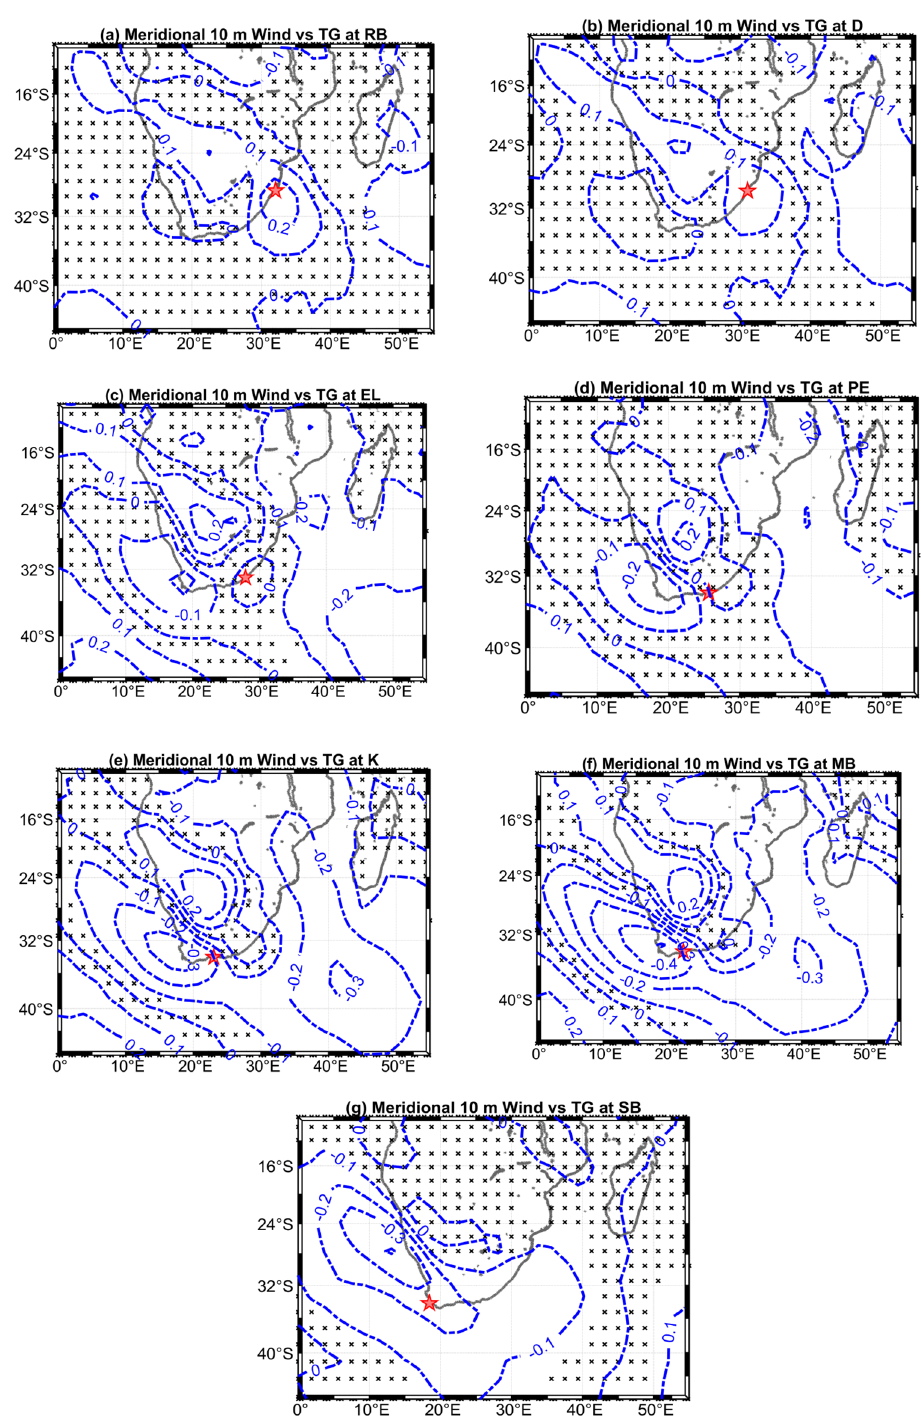
Figure 4. Correlation, on sub-annual timescale, between regional gridded monthly mean meridional wind at 10 m above the mean sea surface and monthly mean SL records at ( a ) Richards Bay, ( b ) Durban, ( c ) East London, ( d ) Port Elizabeth, ( e ) Knysna, ( f ) Mossel Bay and ( g ) Simons Bay, respectively. Red stars indicate the tide gauge location. Black crosses indicate areas statistically non-significant at 95% confidence level, estimated using a two-sided t -test.